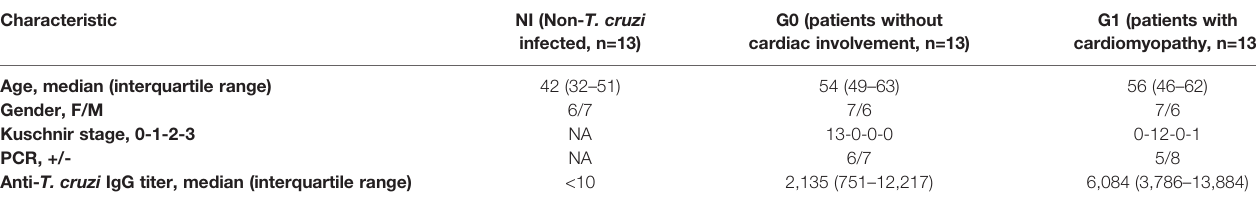
TABLE 1 | Demographic and clinical characteristics of